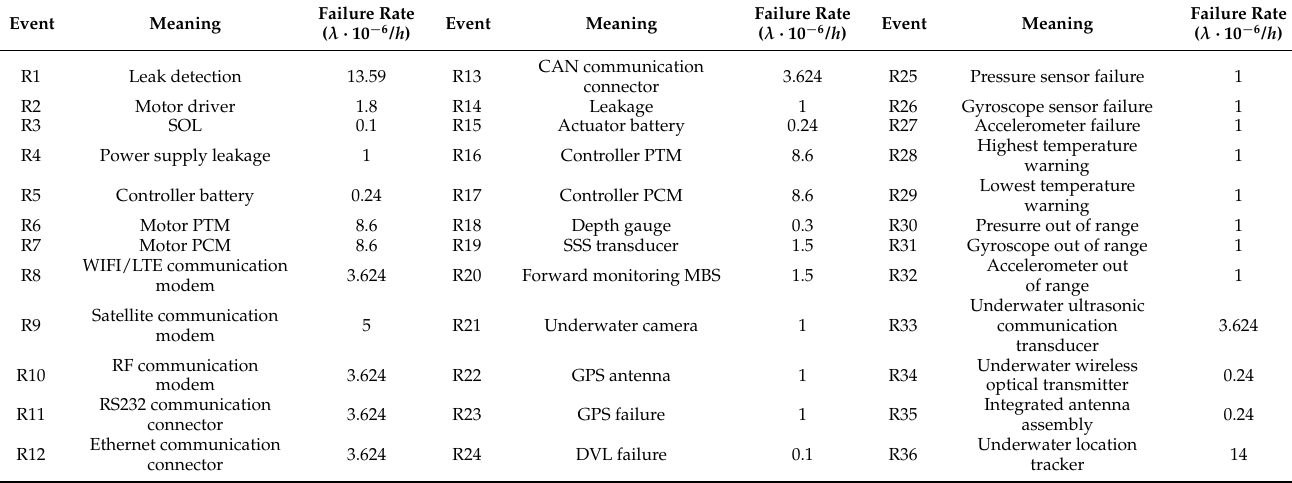
Table 2. Basic reliability event description of the fault